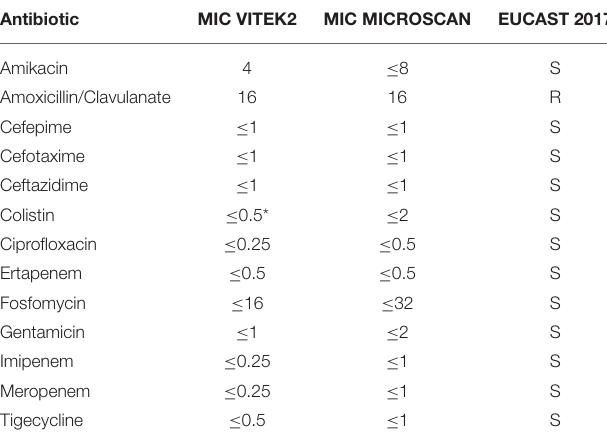
TABLE 2 | Antibiotic susceptibility MICs (expressed as mg/L) of the Y. enterocolitica isolate.